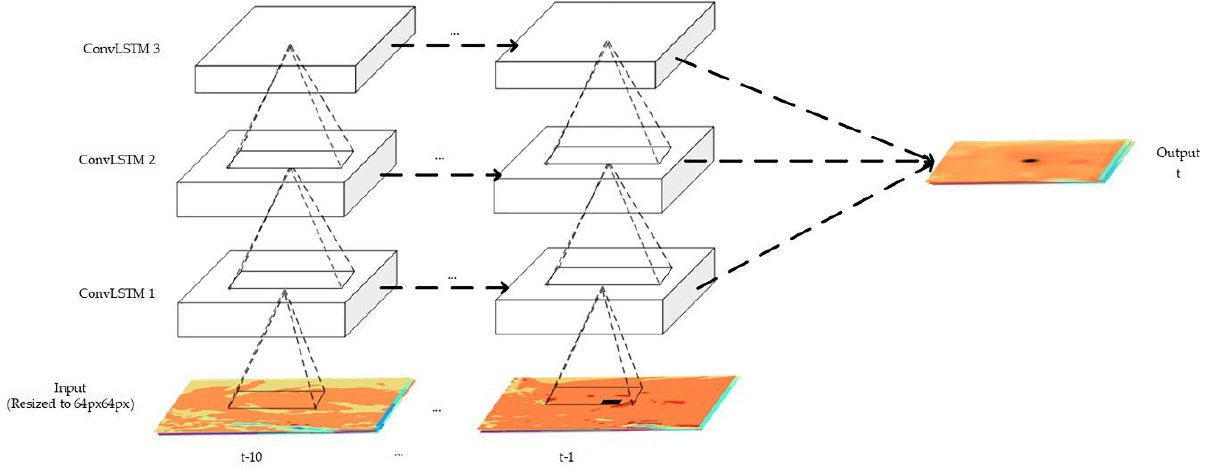
Figure 4. The training process of the ConvLSTM model.